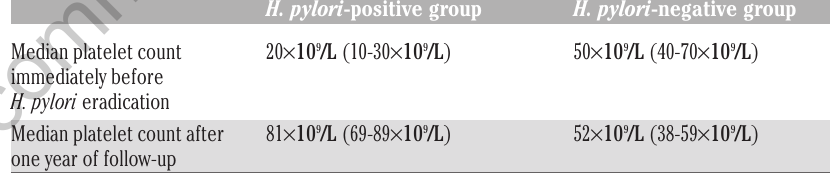
Table 3. Platelet count in H. pylori -positive and -negative patients eradication.